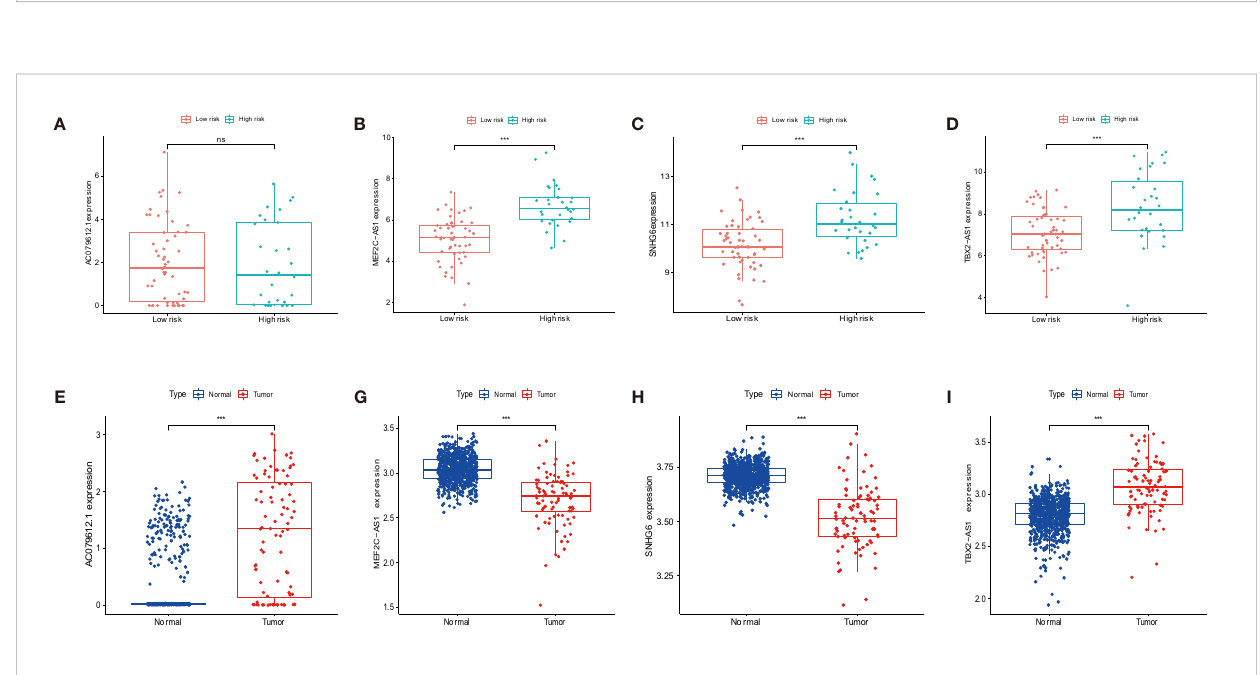
FIGURE 5 Differential expression of target genes in different osteosarcoma risk and tumor and normal tissues for the expression of AC079612.1, MEF2C-AS1, SNHG6, and TBX2-AS1 in various risk groups (A – D) and different tissue types (E – I) . "ns" P > 0.05, *** P < 0.001.